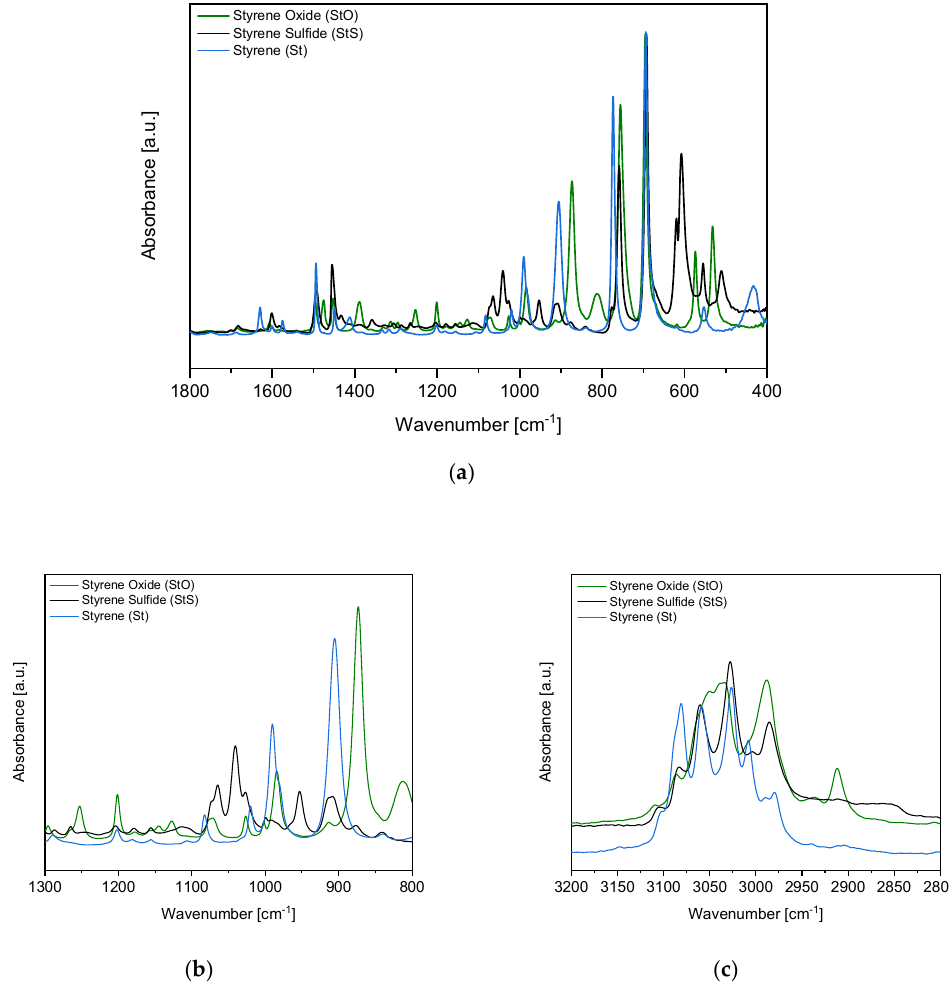
Figure 3. FTIR spectrum of styrene oxide (StO)—substrate, and styrene sulfide (StS)—product (monomer), ( a ) in the middle wavenumber region; ( b ) in the wavenumber region of significant changes; ( c ) in the high wavenumber region. The FTIR spectrum of styrene (St) was added for comparison.